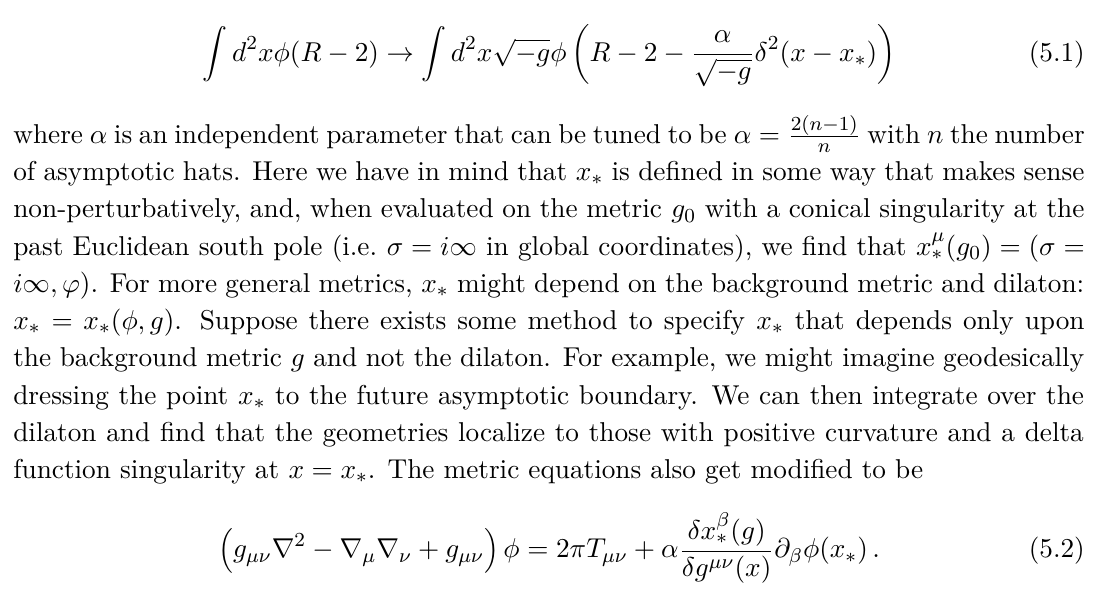
Figure 11. We illustrate the boundary conditions associated to computing the purity, Tr [ ρ 2 the state on Hat L in the Hartle-Hawking state with modified boundary conditions, where the conical singularity (marked by “X”) is inserted in the frozen portion of the geometry. The prime denotes bra vs. ket and the subscript denotes replica number. Since this dressing ties hats of the same replica number to each other, we see that the quantum extremal surface (or its Renyi-2 analog), which gave an answer of S 2 = 0 for each hat, is excluded. The only possibility is the analog of the “Hawking” saddle, which gives a non-zero answer for S 2